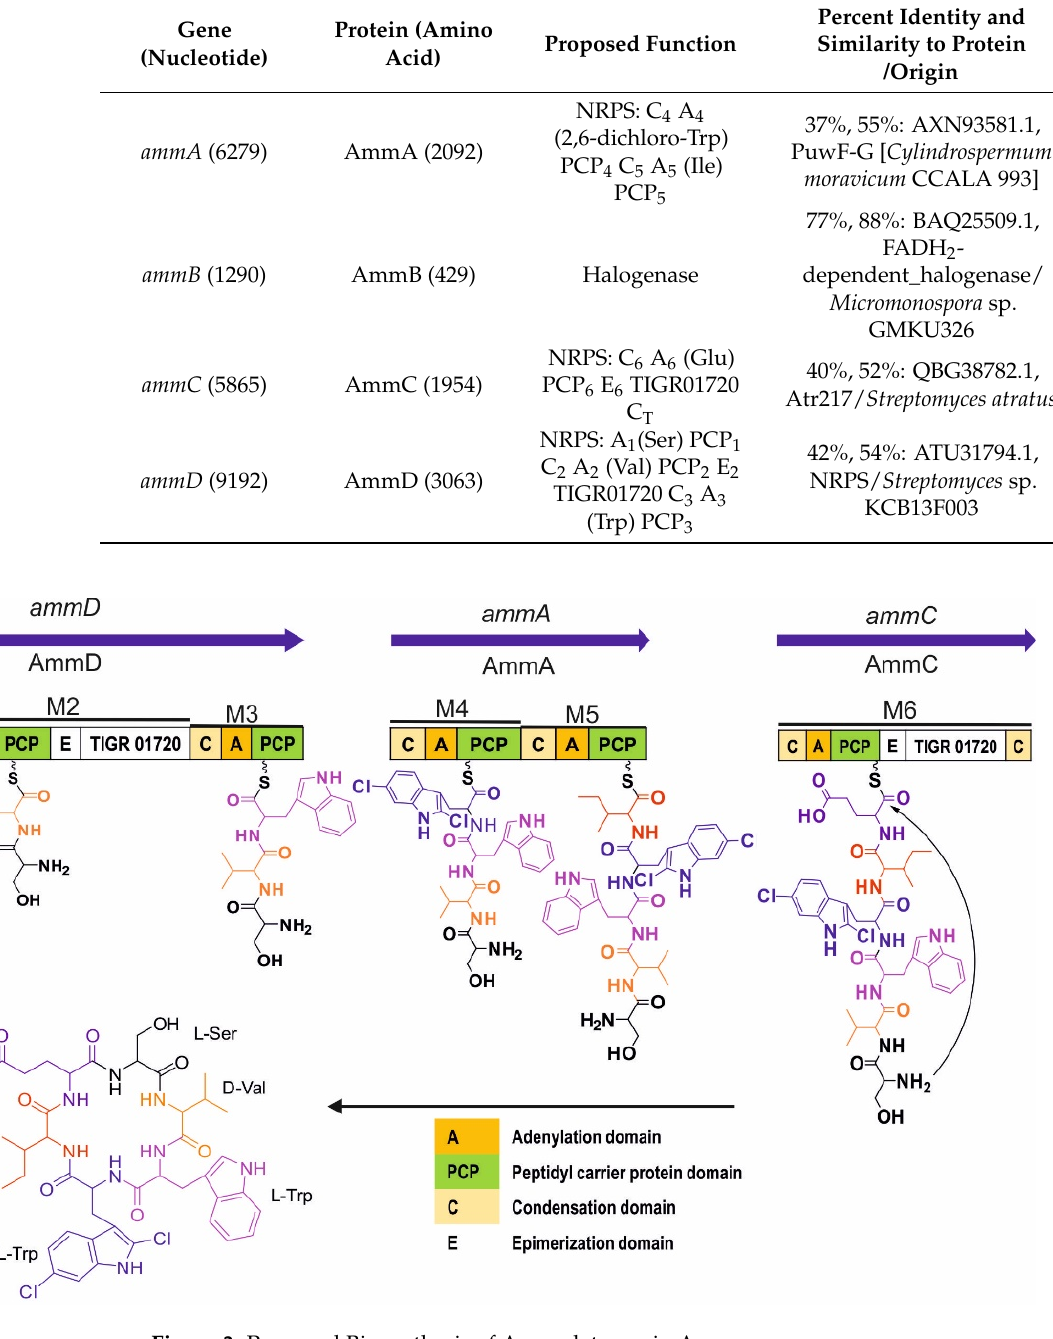
Table 2. List of Biosynthetic Genes and Proteins Putatively Associated with Amycolatomycins.